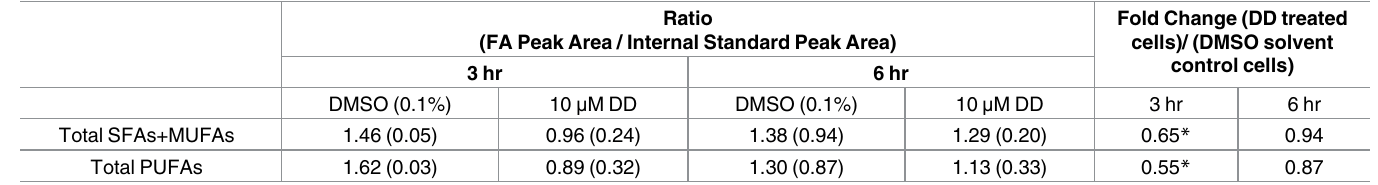
Table 2. Analysis of changes in total saturated and monounsaturated fatty acids compared to that of total polyunsaturated fatty acids in DD treated cells at 3 hr and 6 hr. Data presentedfor 3 hr time point is representative of two independentexperiments; 5–8 biologicalreplicateseach for DMSO and DD treatments. Data for 6 hr time point is representative of three independent experiments; 5–8 biological reps each for DMSO and DD treatments; num- bers in brackets indicate ± SD; Significance * p < = 0.1 calculatedby student’s t-test in comparisonto the control.